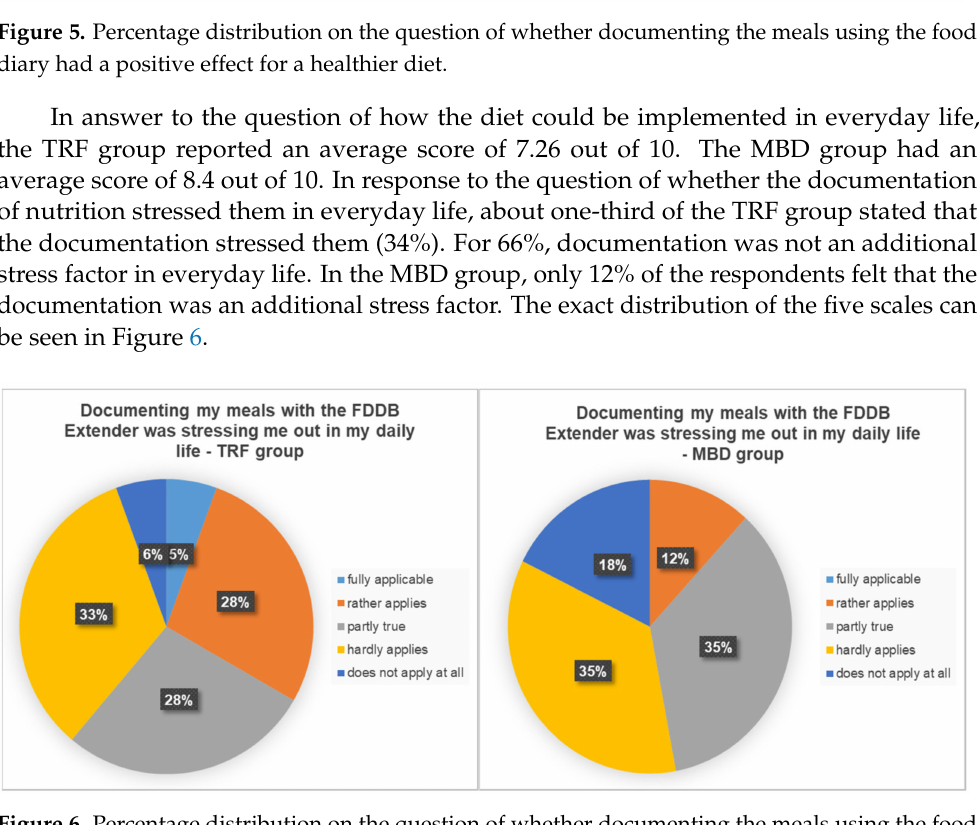
Figure 6. Percentage distribution on the question of whether documenting the meals using the food diary stressed in the daily